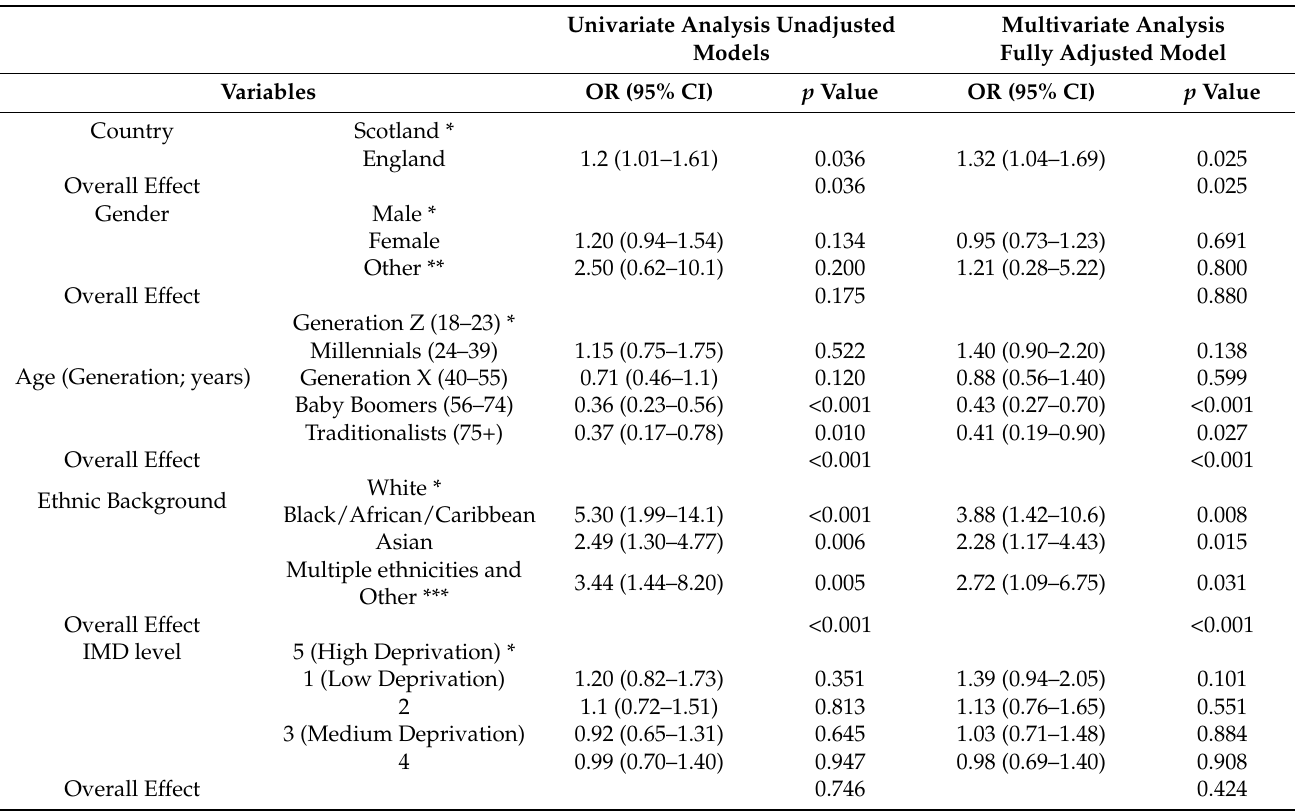
Table 2. Sociodemographic factors of PBAF